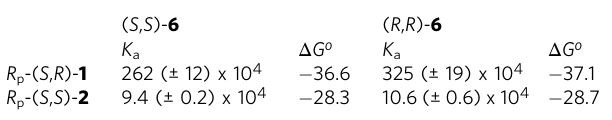
Table 1 Host – guest binding